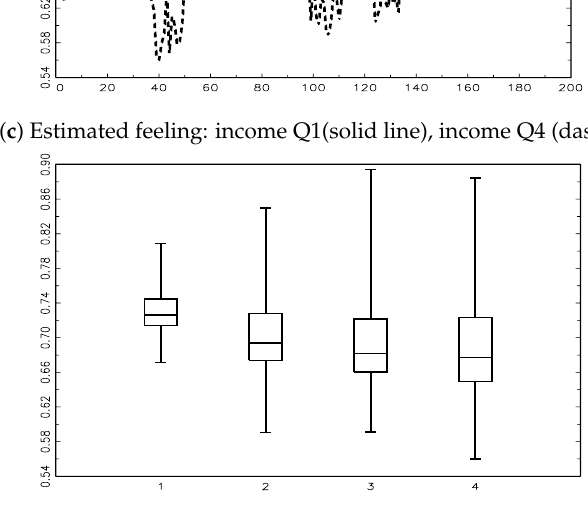
Figure 6. Graphs of time-varying parameters for different income